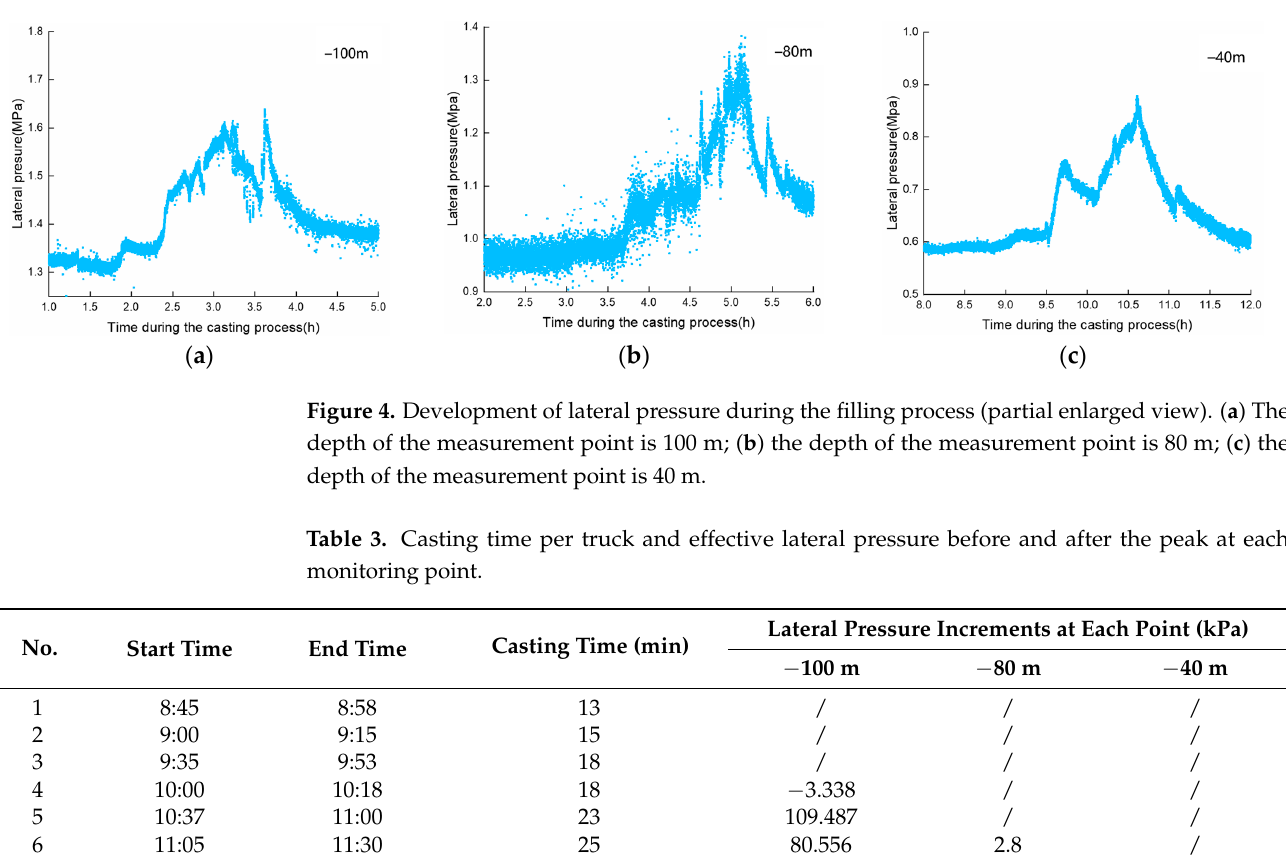
Figure 3. Development of lateral pressure during the filling process.